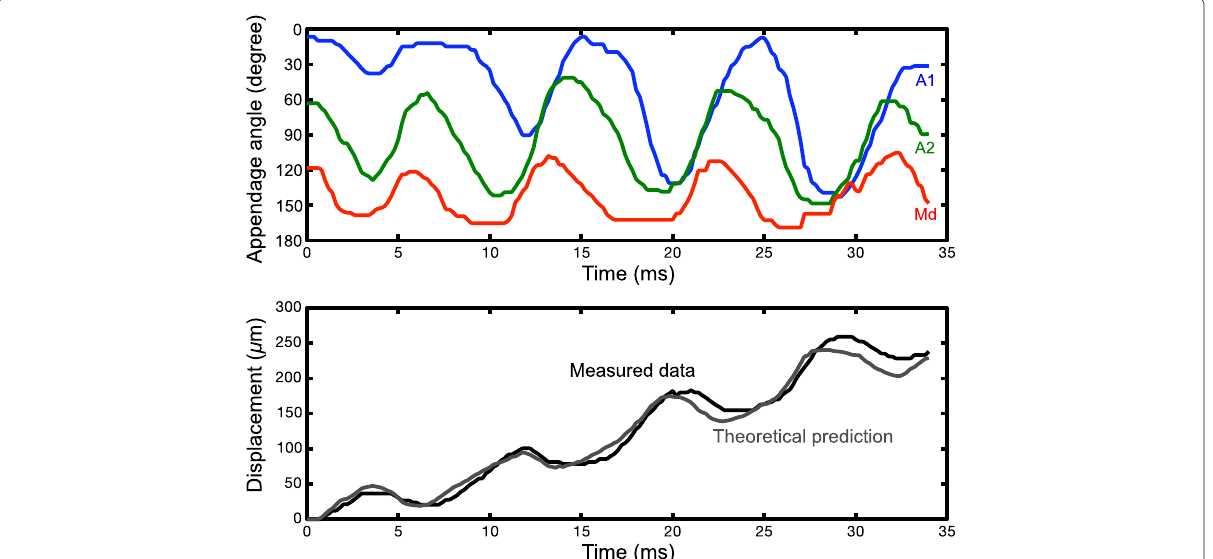
Fig. 21 Model input (Top) and model prediction of naupliar displacement (Bottom). (Top) Lines show the angular position of three appendages as labelled in Fig. 19 at 0.2 ms intervals starting from rest (T = 0 ms) to completion of fourth return stroke (T = 32 ms) from an observed swim episode. Top line: A1 (blue); middle line: A2 (green); and bottom line: Md (red). (Bottom) Copepod displacement over time: observed (black line) and theoretical model prediction